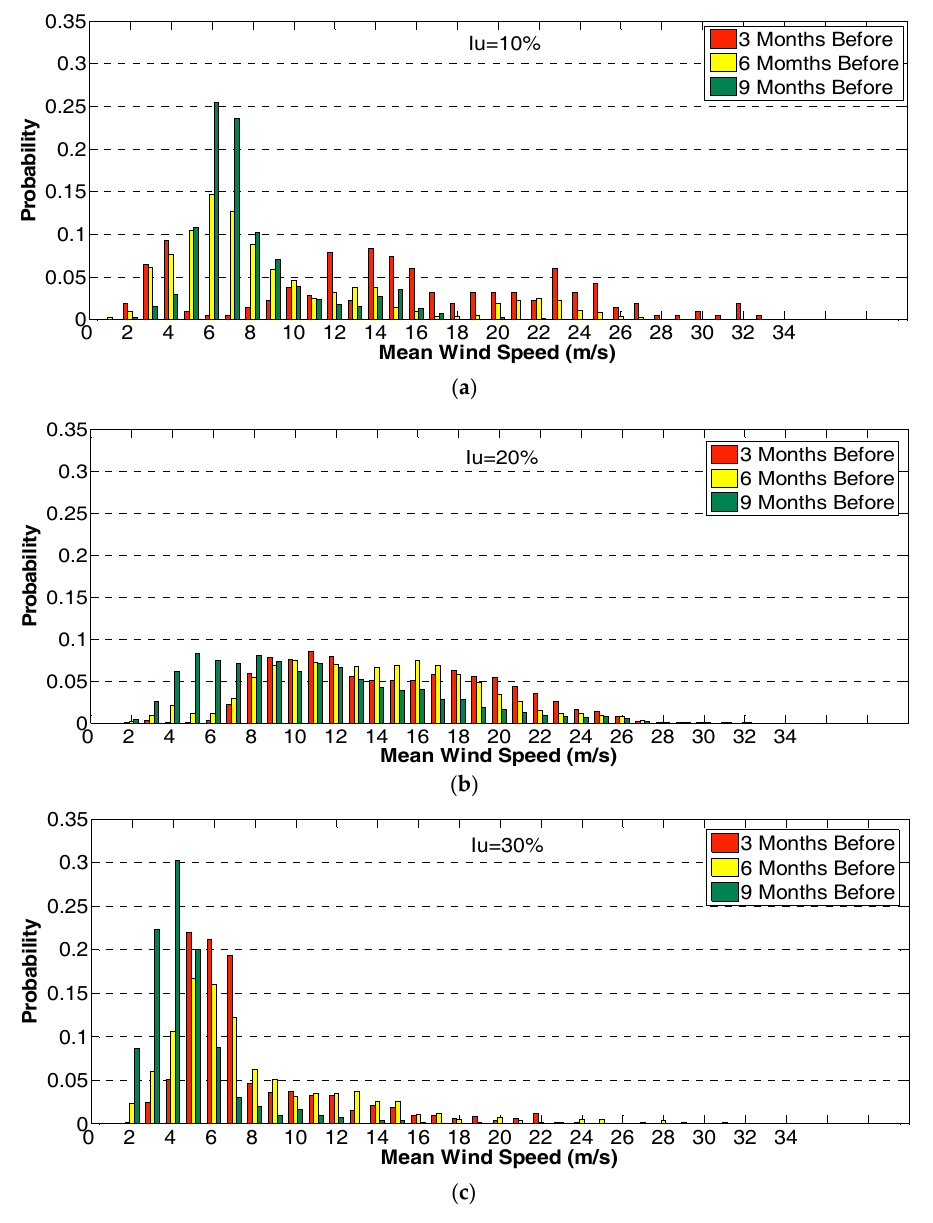
Figure 17. Distribution of mean wind speeds of different periods recorded by SCADA with different turbulence intensity: ( a ) 10%; ( b ) 20% and ( c ) 30%.